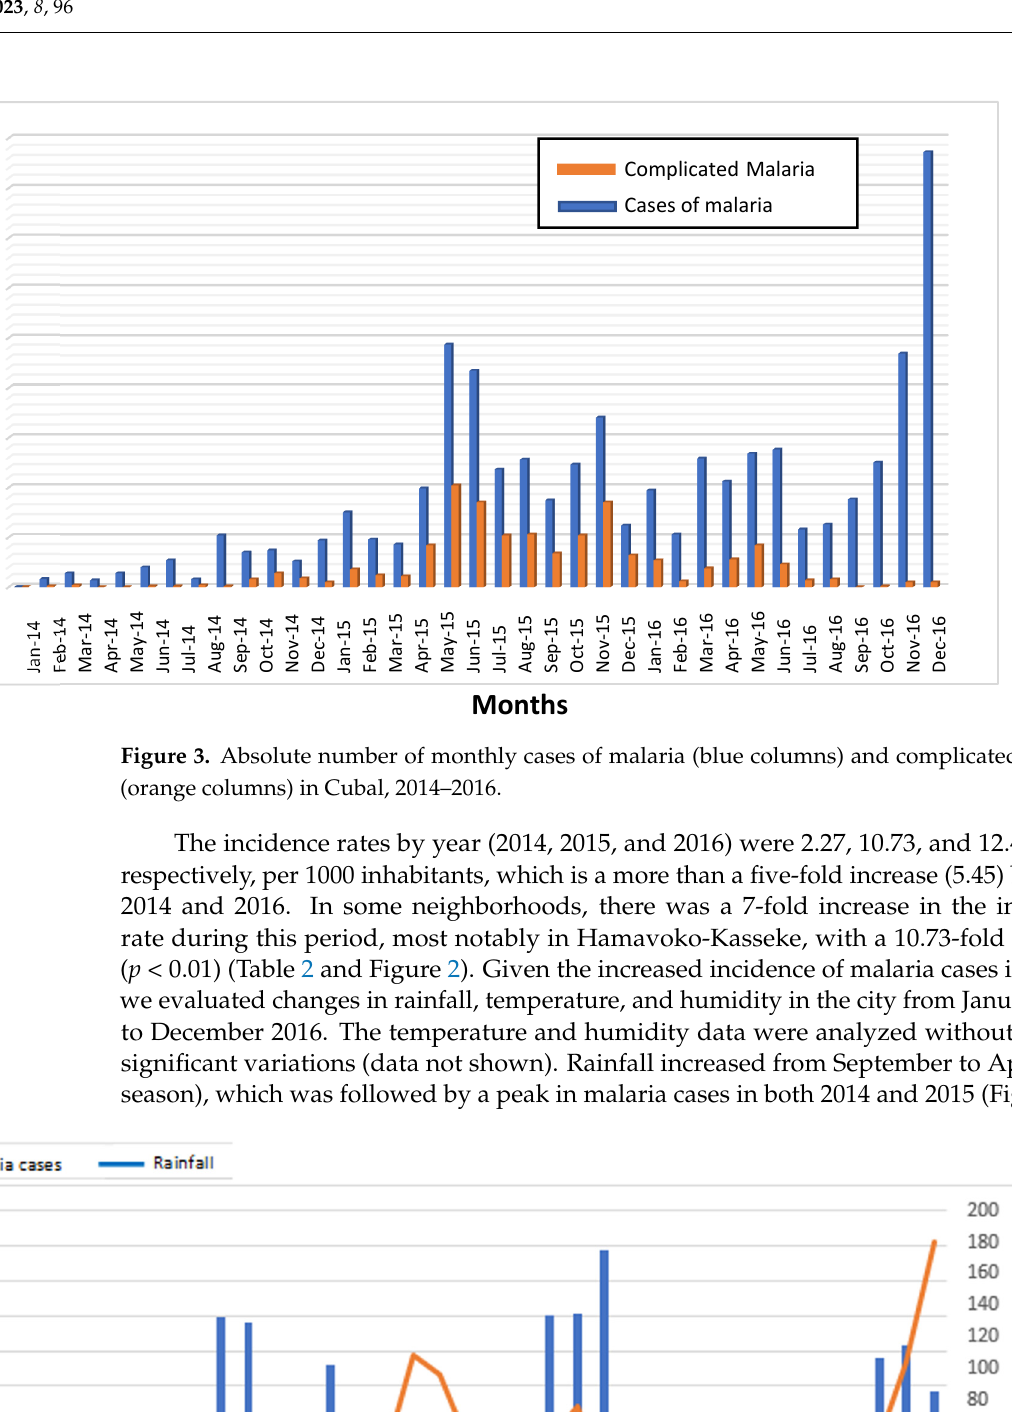
Table 2. Incidence rates (cases per 1000 inhabitants) by neighborhood in Cubal, Angola, 2014 to 2016.